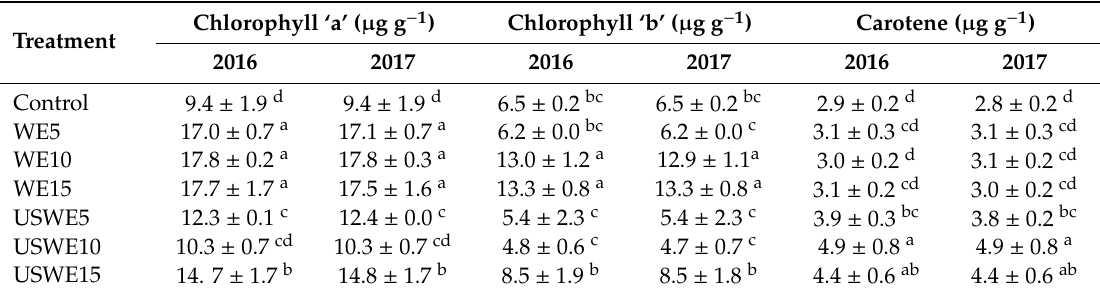
Table 3. E ff ects of water extract (WE) and Ultrasound-Assisted Water Extraction (USWE) on chlorophyll ‘a’, chlorophyll ‘b’, and carotene concentrations in Jew’s Mallow during the 2016 and 2017 growing